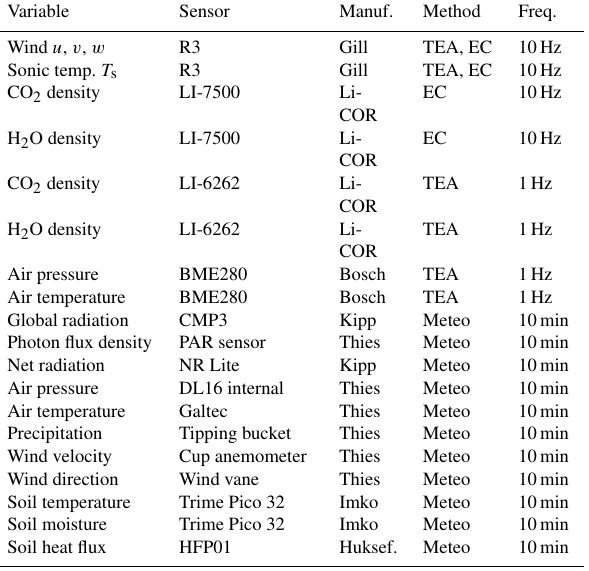
Table 1. Instrumentation used for turbulent flux and meteorologi- cal measurements. Manufacturer key: Gill Instruments (Lymington, UK), Li-COR Environmental Inc. (Lincoln, Nebraska, USA), Kipp & Zonen B.V. (Delft, The Netherlands), Bosch Sensortec (Stuttgart, Germany), Adolf Thies GmbH & Co. KG (Göttingen, Germany), Imko Mikromodultechnik GmbH (Ettlingen, Germany), Hukseflux Thermal Sensors B.V. (Delft, the